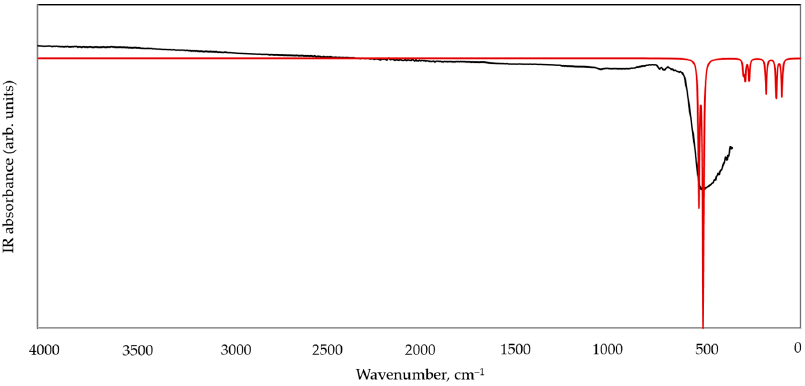
Figure 10. IR spectra of BaOsF 6 : experimentally observed (black) and calculated with DFT-PBE0 (red).